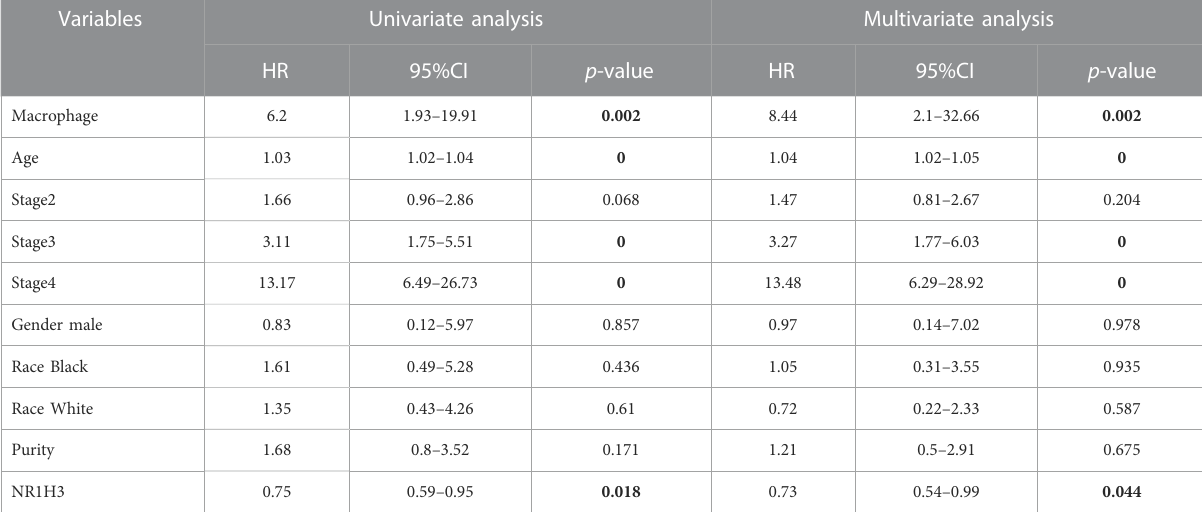
TABLE 2 Univariate and multivariate analysis of prognostic variables of OS in BRCA.